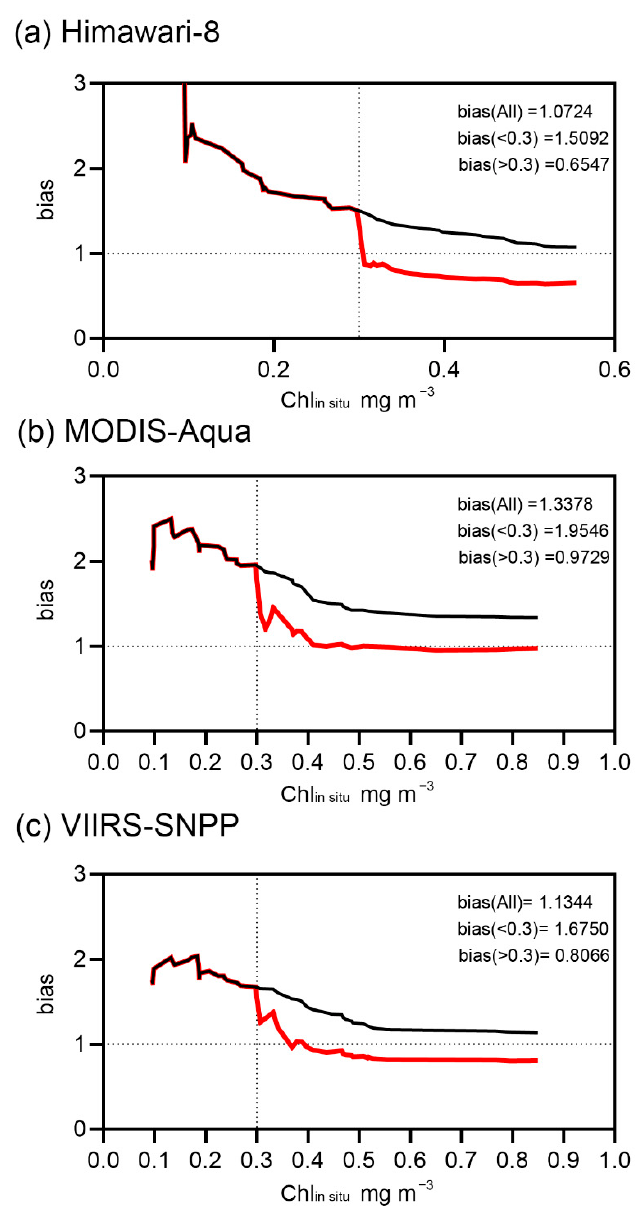
Figure 5. Bias variation of the three satellites. The black lines are the bias variation for the total data set; the red lines are the bias variation after data grouping based on a 0.3 mg m − 3 threshold in situ Chl-a concentration (the red lines of the Chl in situ < 0.3 mg m − 3 group are overlapped by the black lines).